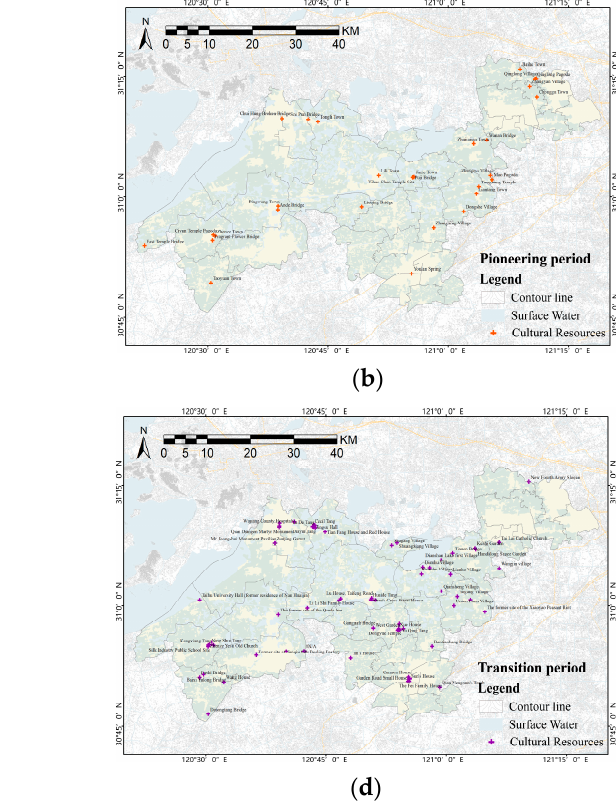
Figure 5. Quantitative analysis of cultural resources in the demonstration area under different his- torical periodizations.